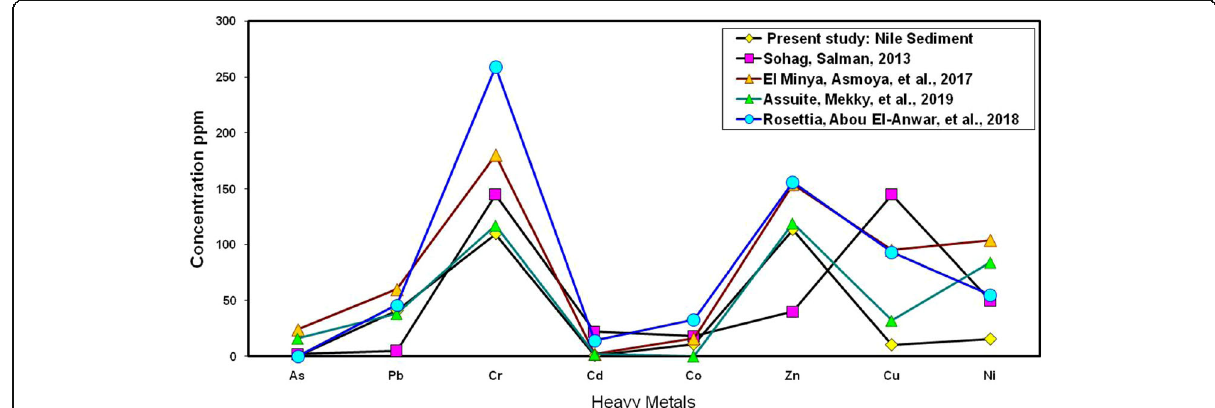
Fig. 10 Comparison the heavy metals study with other